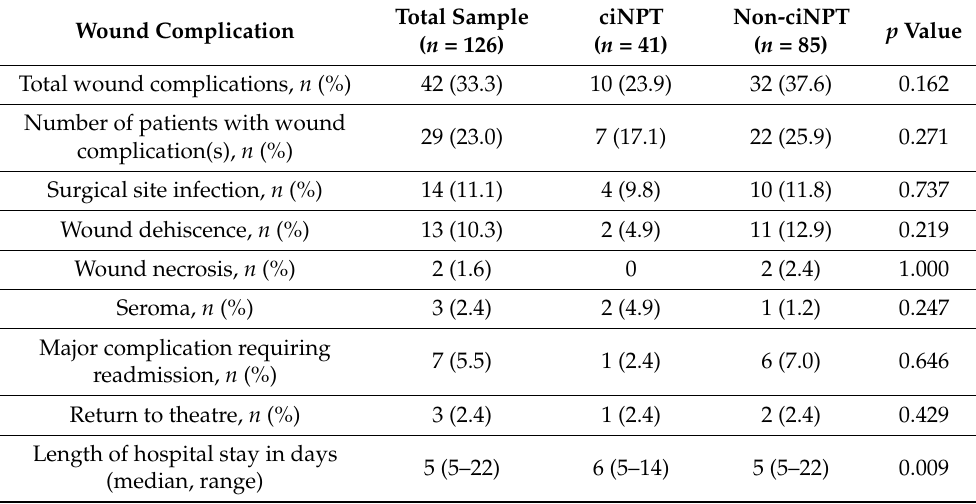
Table 3. Postoperative outcomes: ciNPT vs. non-ciNPT patients. Wound